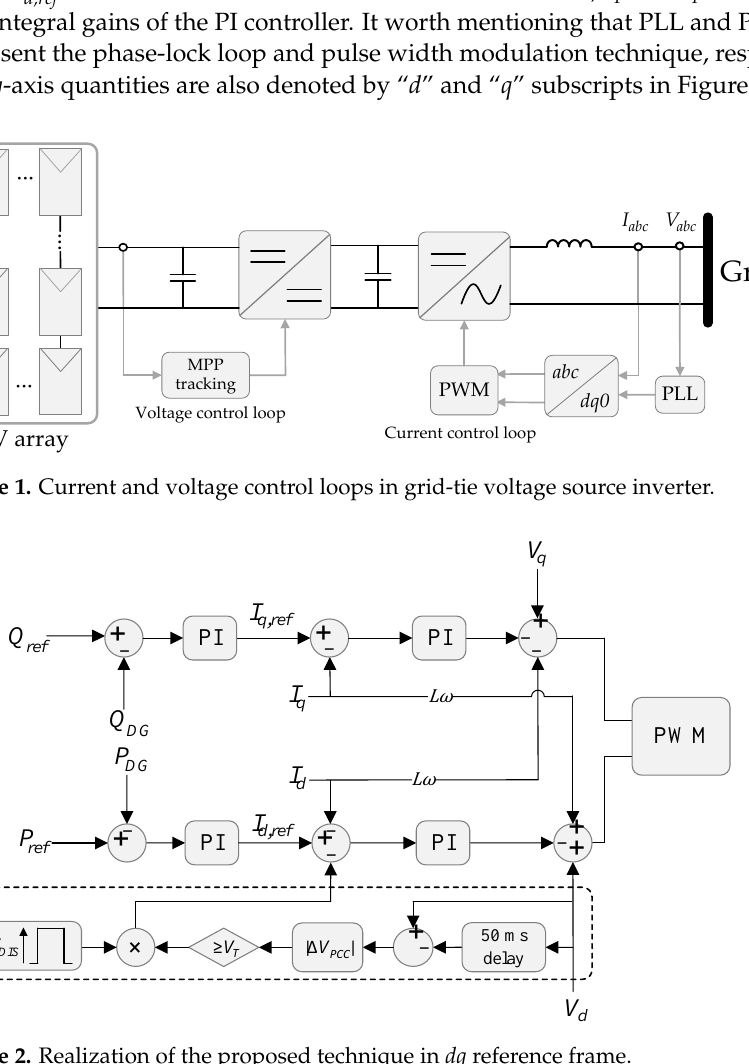
Figure 2. Realization of the proposed technique in dq reference frame.